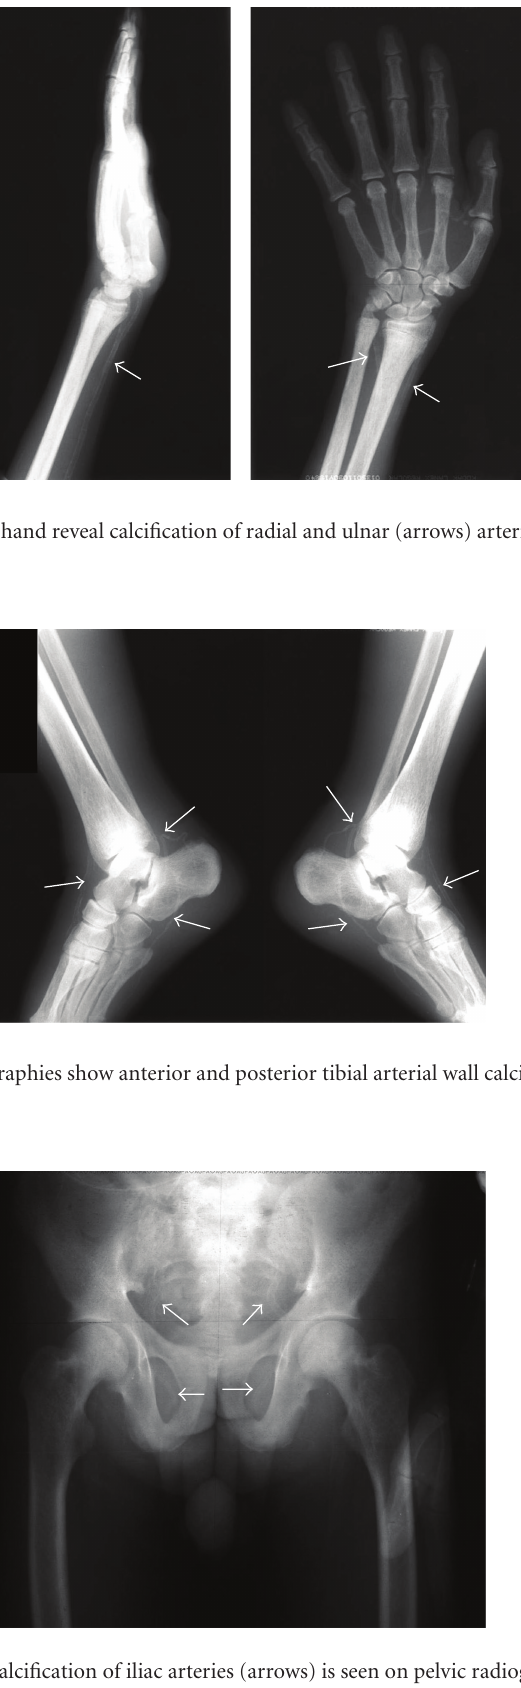
Figure 3: Calcification of iliac arteries (arrows) is seen on pelvic